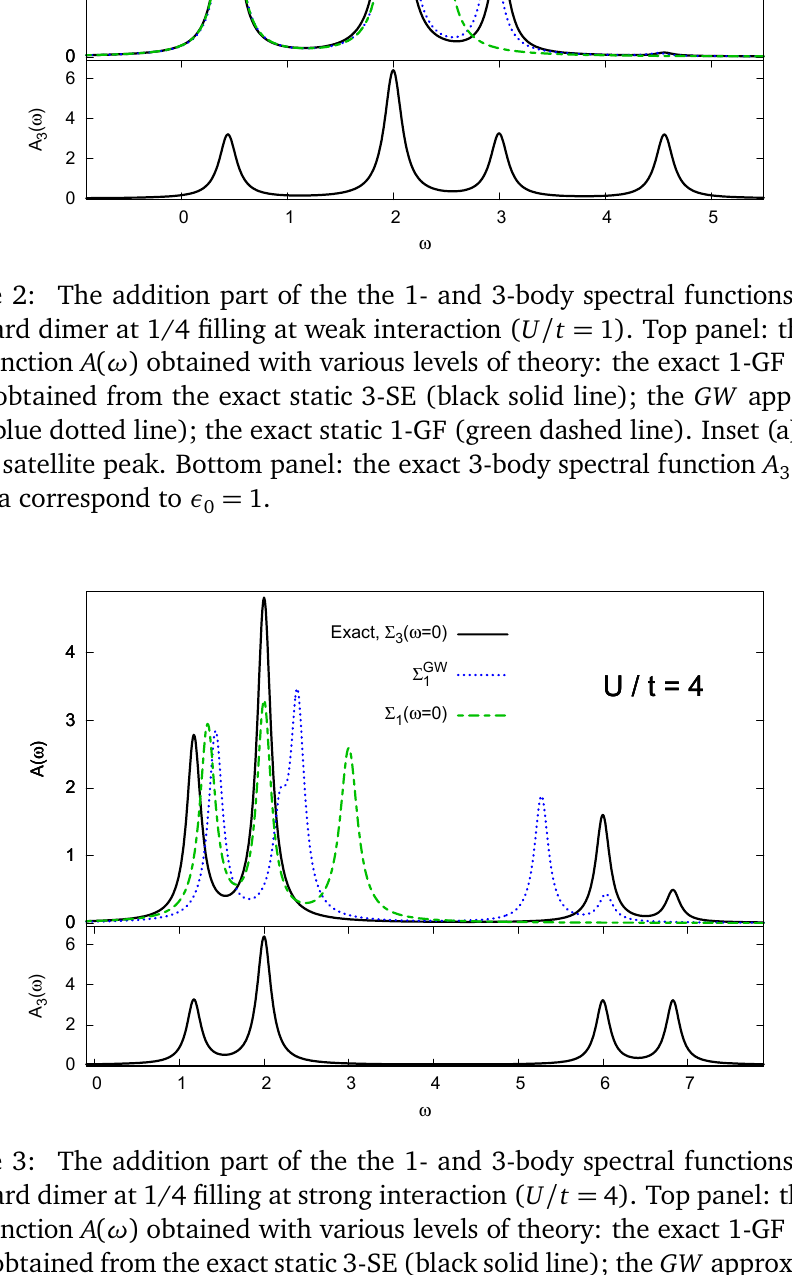
( ω ) . All spectra 3